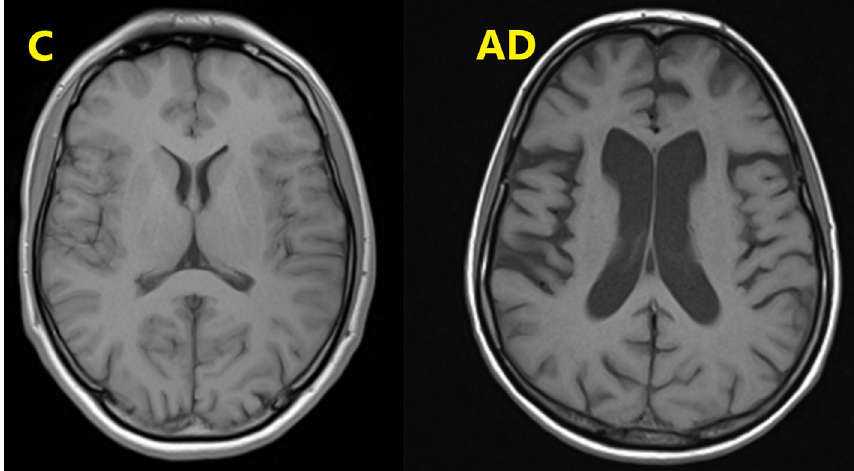
Figure 1. Visual examples of the brain atrophy changes in patient suffering from Alzheimer’s disease (AD; atrophy of the temporal and frontal lobes) with ventricular enlargement, in comparison to the non-demented control person (C).